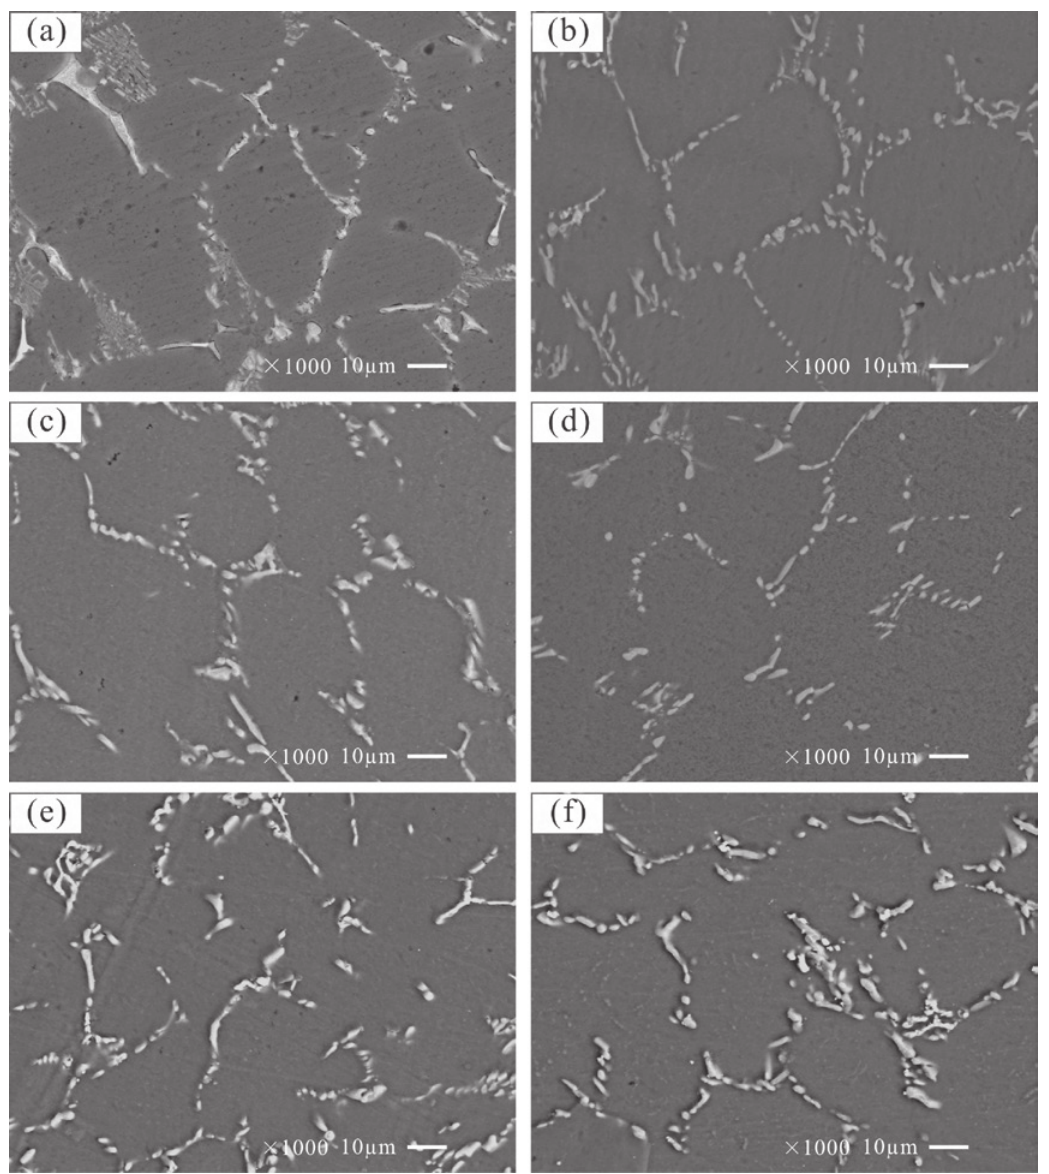
Fig. 4: SEM microstructure of as-cast alloy 2618 and the alloys homogenized at 500 °C for different times: (a) as-cast; (b) 8 h; (c) 12 h; (d) 16 h; (e) 20 h; (f) 24